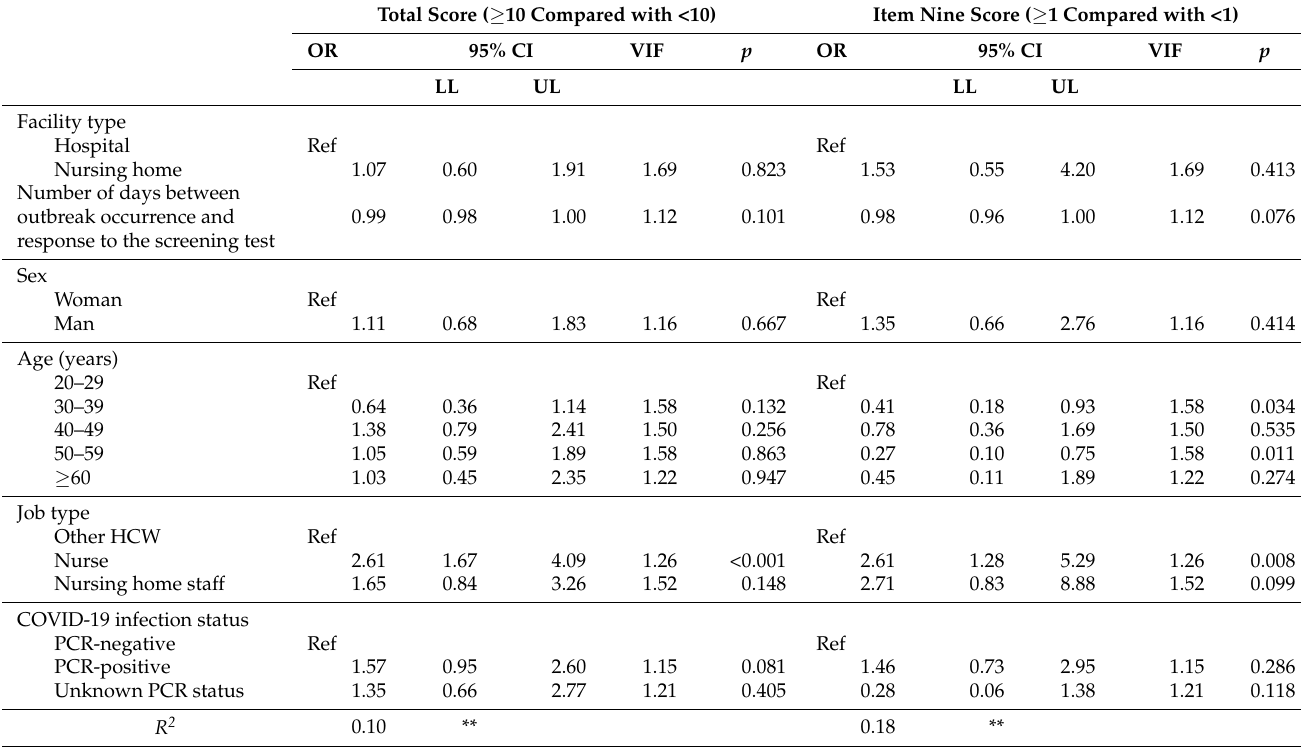
Table 3. Multiple logistic regression analysis for PHQ-9 ( n =